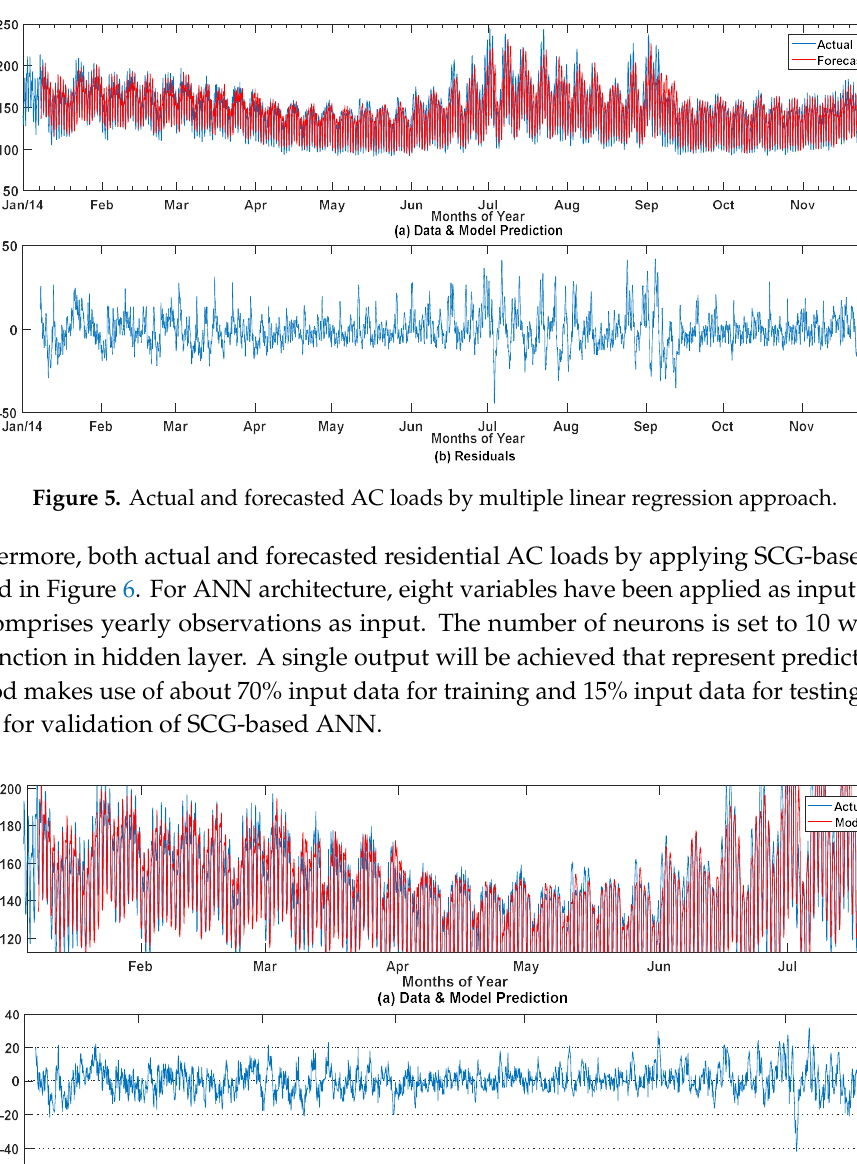
Figure 4. AC Load variations due to ( a ) Dew Point Temperature ( b ) Dry Bulb Temperature.